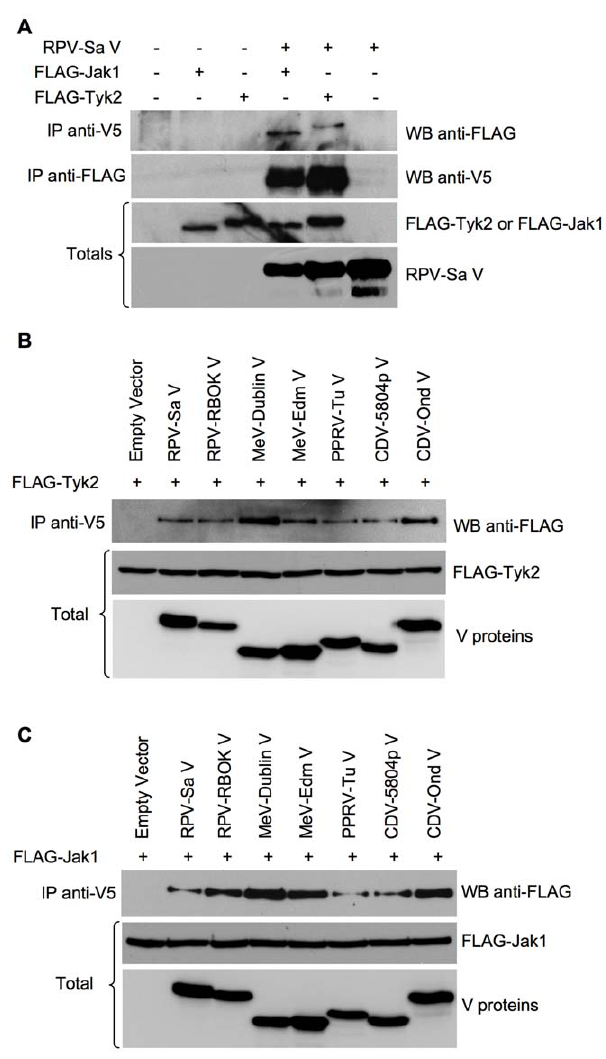
Figure 9. All morbillivirus V proteins co-precipitate Jak1 and Tyk2. (a) Vero human-SLAM cells (b), (c) HEK 293FT cells were co- transfected with 1 m g of empty vector or plasmids encoding the indicated proteins along with 2 m g pFLAG-Jak1 or pFLAG-Tyk2. Forty- eight hours post-transfection, cells were lysed with NP-40 lysis buffer (pH 7.5) and the lysates were immunoextracted with mouse anti-V5 or mouse anti-FLAG antibodies as described in ‘‘Materials and methods’’. The immunoprecipitates and the total cell lysate (1/10) were analyzed in Western blots for the presence of FLAG-Jak1 or FLAG-Tyk2 and the expected V proteins. The primary antibodies were detected with peroxidase-labelled anti-mouse IgG antibody.